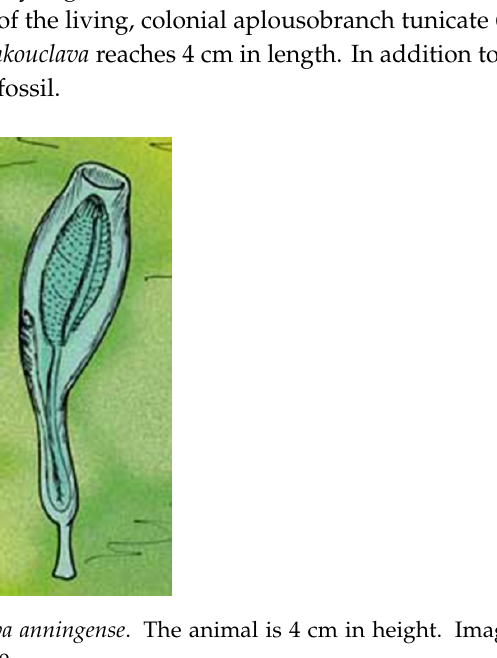
Figure 4. Cambrian tunicate Shankouclava anningense . The animal is 4 cm in height. Image credit: Apokryltaros. Used here per CC BY-SA 3.0.